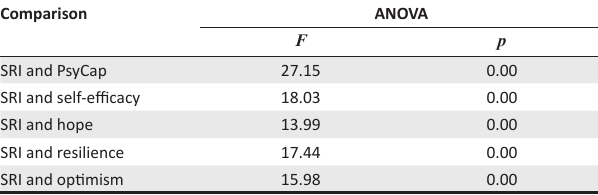
TABLE 4: One-way ANOVA results. Comparison